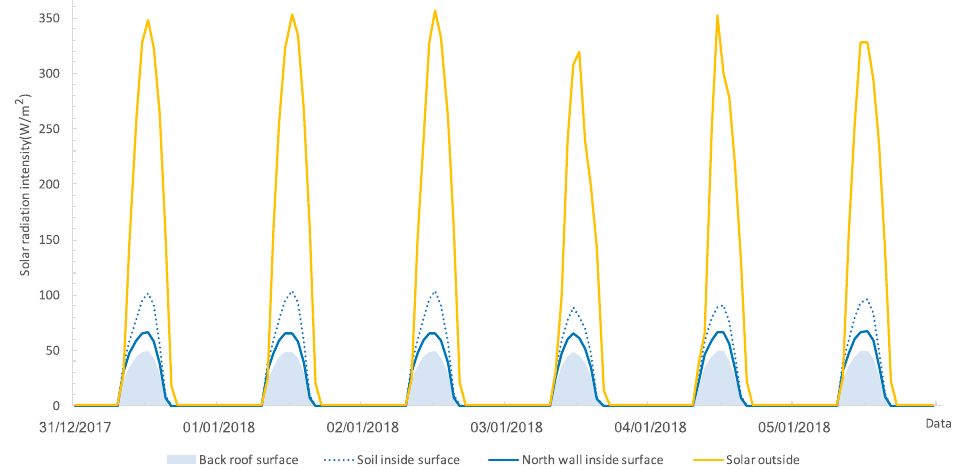
Figure 20. Solar radiation heat gain rate inside the surfaces of the CSG on clear days.